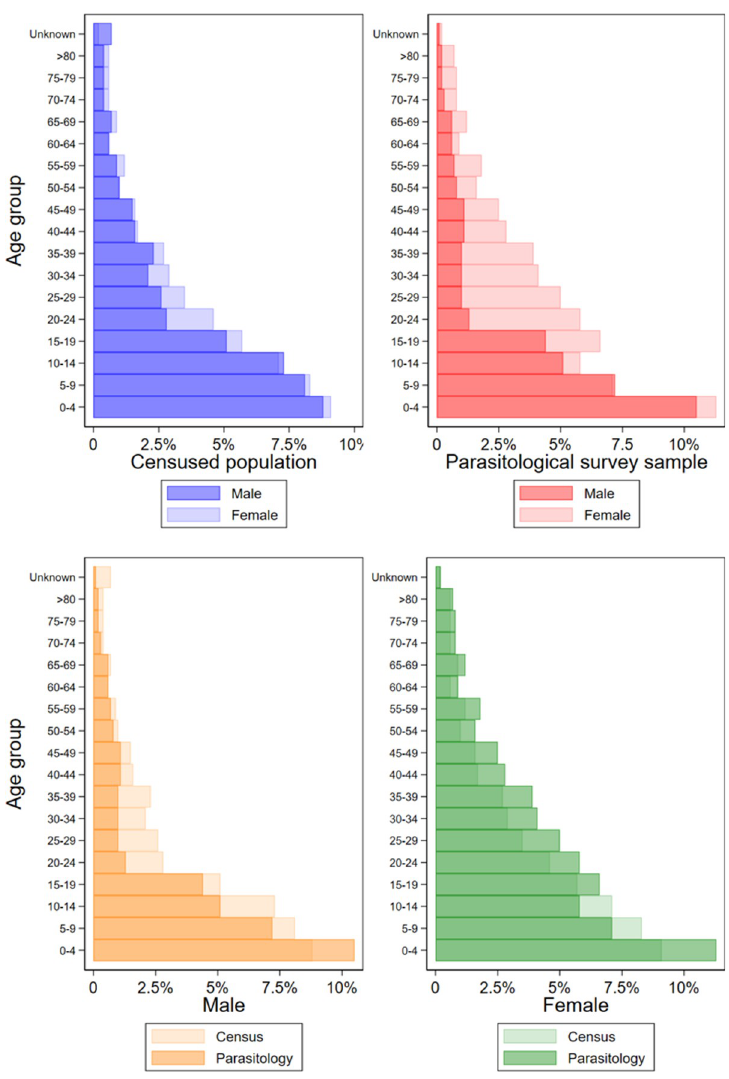
Fig 3. Population structure of census and participation in parasitological survey by age group and